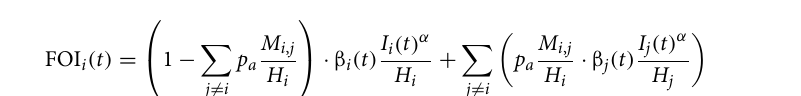
Figure 2. Time series of daily number of hospital beds needed across five possible intervention scenarios in a fictional location with nine counties. Lines represent results from 50 stochastic model simulations. Horizontal black lines represent the total hospital bed capacity in the fictional location, assumed to be n = 8661 (3 beds per 1000 population). The colored horizontal bars along the top visualize the effectiveness of interventions at a given time point along a dark blue to light blue spectrum; dark blue indicates a period with no reductions to transmission, while light blue indicates a period with more restrictive action (i.e., low transmissibility). In the fifth scenario, “Social Distancing Checker,” only three of nine counties implement any non-pharmaceutical interventions, thus differentiating it from “Social Distancing